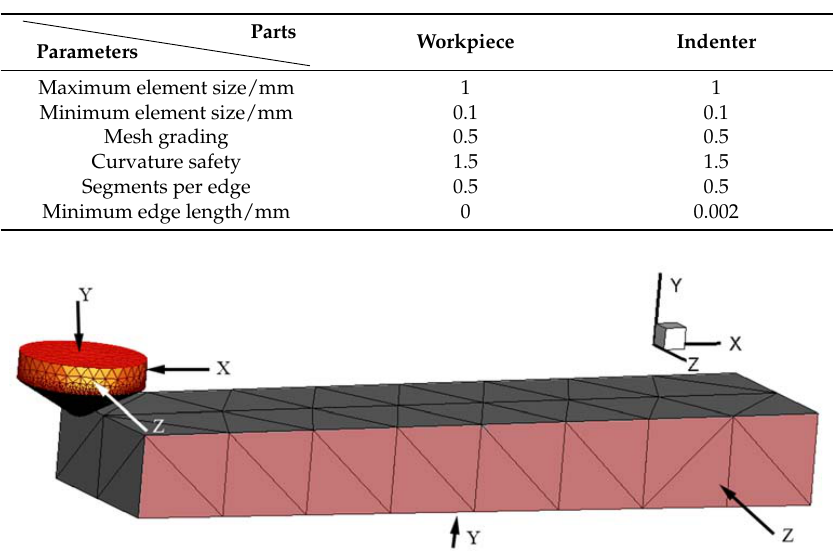
Figure 4. 3D simulation model and boundary conditions.